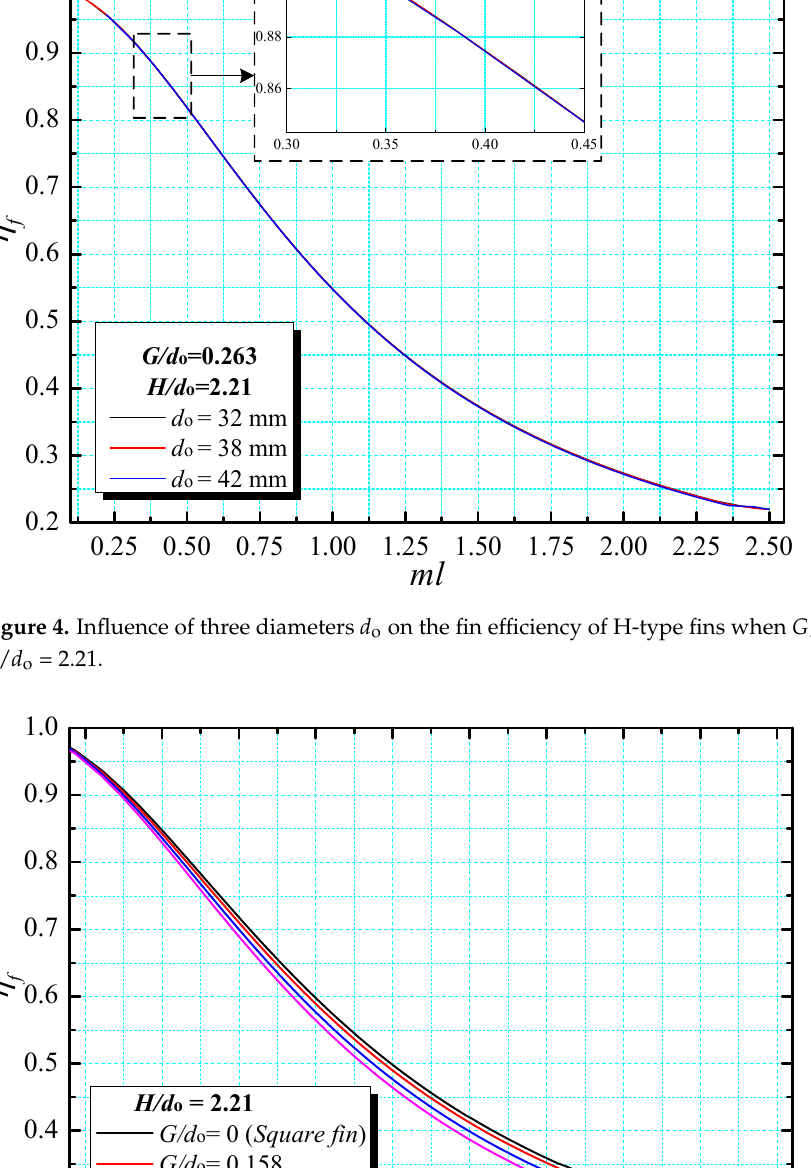
quired by means of numerical simulations when ml ranges from 0 to 2.5. The linear nom- ograms and corresponding fitting polynomials derived from simulated data under three diameters (32, 38, and 42 mm) are shown in Figures 6–8, where H = A and is uniformly expressed by H . The fin efficiency of H-type fins in the fitting formulae is expressed by y , and ml is expressed by x . The fin efficiency of H-type fins can be directly calculated ac- cording to the fitting formula without repeatedly querying the linear nomograms in the iterative process. Considering the heat transfer at the edge of H-type fins, the dimension in the direction of fin thickness needs to be extended to the dimension in the two-dimen- sional fin plane, so ( H − d o + 2 δ )/2 is assigned to l when calculating the fin efficiency of H- type fins by means of the fitting formulae. These values adapt to the general structures of H-type fins and meet the requirements of common calculations. While H / d o or G / d o are not the given values in these linear nomograms, the interpolation method is recommended.